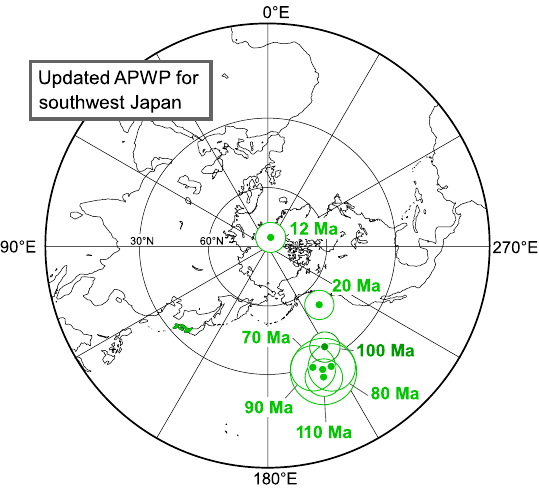
Fig. 7 Analysis of the orthogonal plots of thermal demagnetization results of Kodama and Takeda (2002) showing a true component C (high-temperature component)